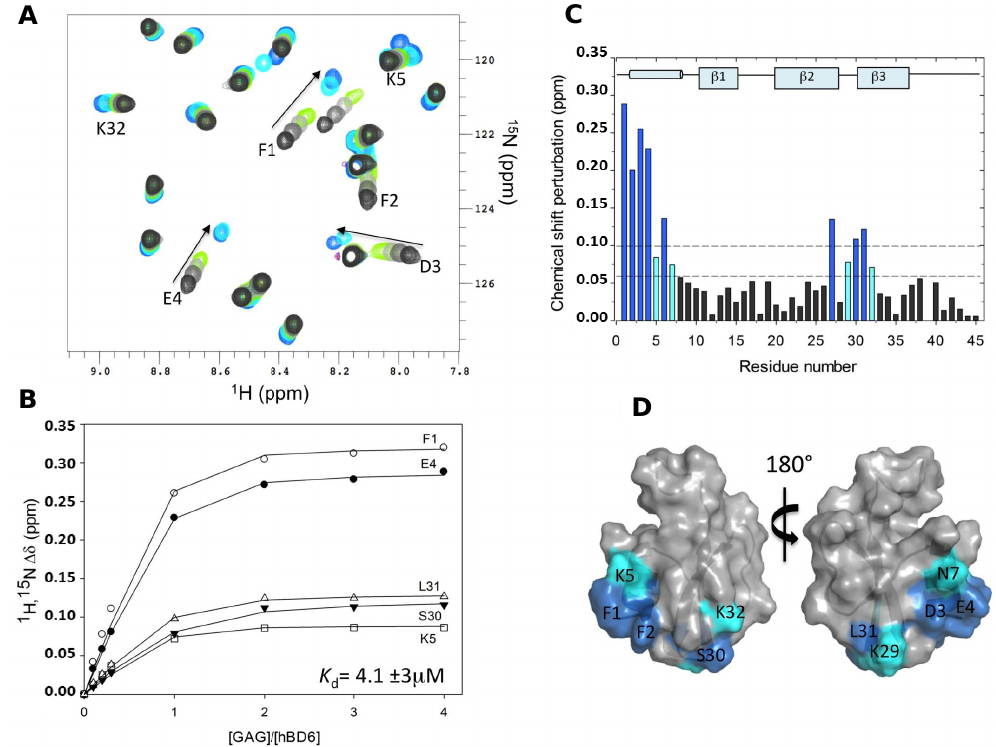
Figure 3. Interaction of human beta-defensin 6 (hBD6) with fondaparinux (Fx) by chemical shift perturbation (CSP) analysis. ( A ) A section of the 15 N-edited heteronuclear single quantum coherence ( 15 N-HSQC) spectra of the free hBD6 (black) and in the presence of heparin pentasaccharide Fx. The arrow indicates the direction of binding-induced chemical shift changes; ( B ) Representative binding profile for calculating the binding constant of hBD6-Fx interactions; ( C ) CSP map of hBD6-Fx interactions. The change seen for individual residues were judged in cutoffs (dotted lines) of 0.06 (light cyan) and 0.10 (dark cyan) ppm. The sequence-specific secondary structural elements are shown on the top of the CSP map; ( D ) Surface representation of hBD6 residues that are significantly perturbed on heparin pentasaccharide binding. The perturbed residues are shown in blue and cyan. Republished with permission of ASBMB J. Biol. Chem. from Unique properties of human β -defensin 6 (hBD6) and glycosaminoglycan complex: sandwich-like dimerization and competition with the chemokine receptor 2 (CCR2) binding site. de Paula V.S., Pomin V.H., Valente A.P.; 289, 33, 2014; permission